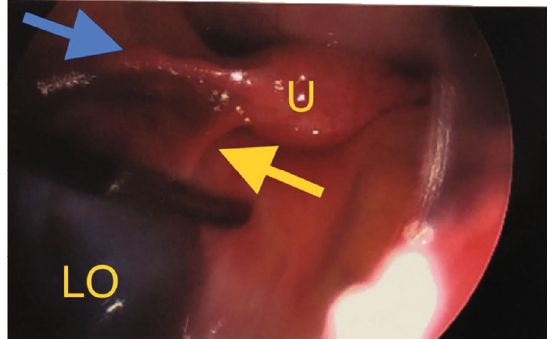
Figure 5: Intraoperative view of the uterus (U), round ligament (blue arrow), detorsed utero-ovarian ligament (yellow arrow) and left ovary (LO).